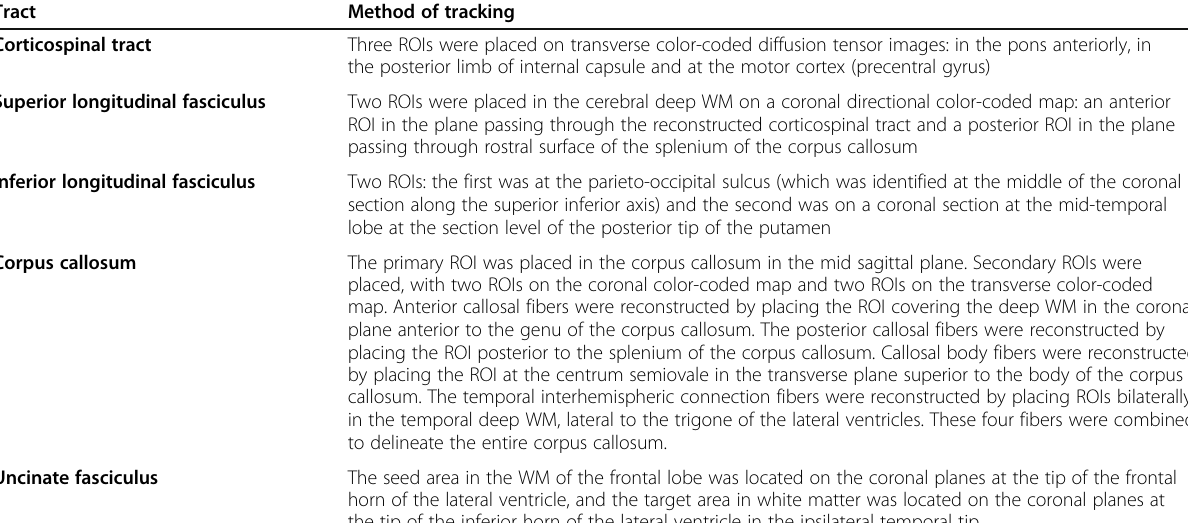
Table 1 Method of tracking the white matter fiber tracts Tract Method of tracking Corticospinal